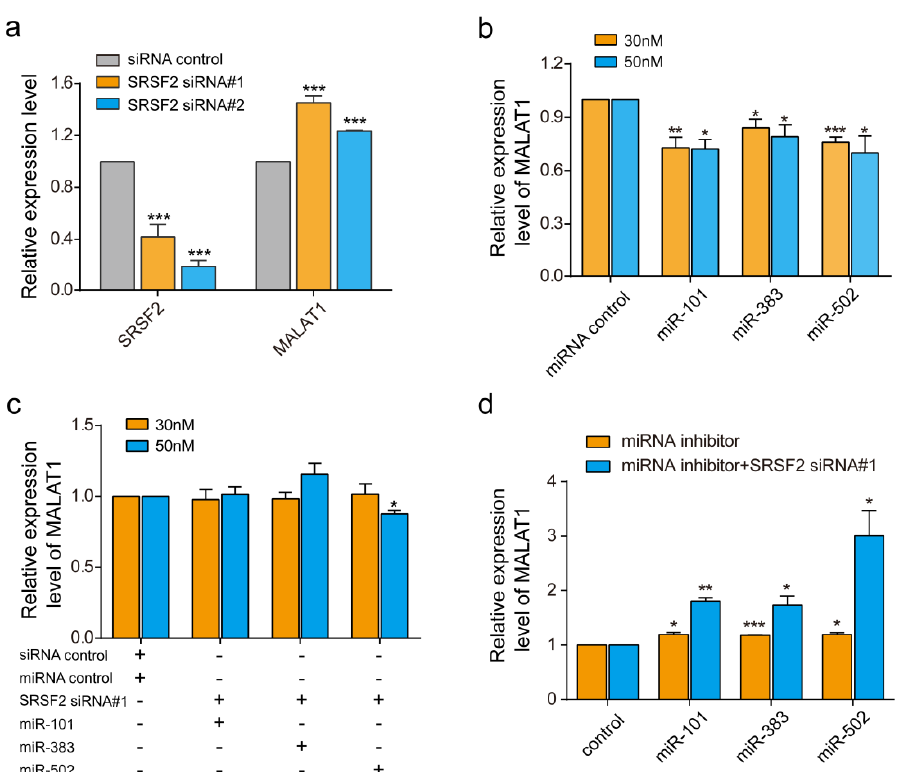
Figure 2. Experimental confirmation of predicted competition between miRNAs and RBPs. ( a ) SRSF2 and MALAT1 expression in TE1 cells treated with two small interfering RNA (siRNA)-SRSF2 and control siRNAs. ( b ) Quantitative real time polymerase chain reaction (qRT-qPCR) for MALAT1 in TE1 cells after transfection with miR-101, miR-383 and miR-502. ( c ) qRT-PCR of MALAT1 in TE1 cells after co-transfection with both siRNA-SRSF2 and miRNAs. ( d ) qRT-PCR of MALAT1 in TE1 cells after co-transfection with both siRNA-SRSF2 and miRNAs inhibitors. * p < 0.05, ** p < 0.01, *** p < 0.001. The concentrations of miRNA mimics were tested at both 30 nM and 50 nM. The concentrations of miRNA inhibitors were tested at 100 nM. Data are the means ± standard error of mean (s.e.m.) of three experiments.